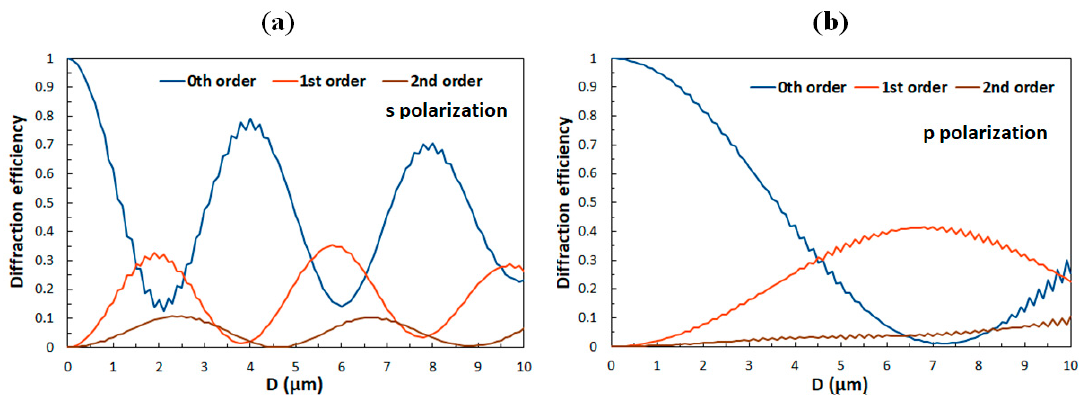
Figure 7. Diffraction efficiencies of the 0th, 1st, and 2nd diffraction orders as a function of the thickness D of the grating assembly for ( a ) the s-polarized and ( b ) the p-polarized incident beam in the zero magnetic field.